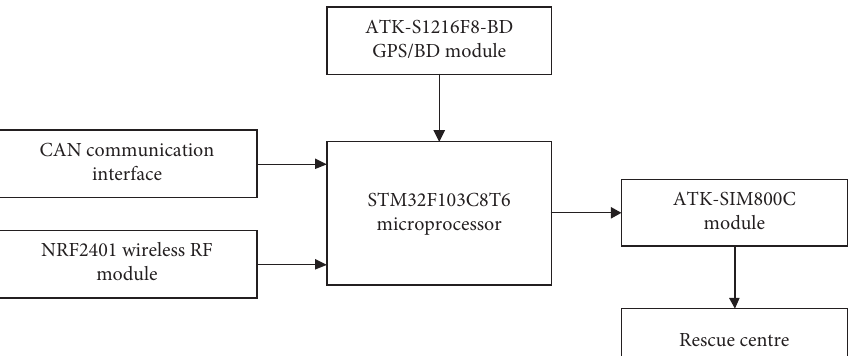
Figure 21: Diagram of the ACNS terminal.